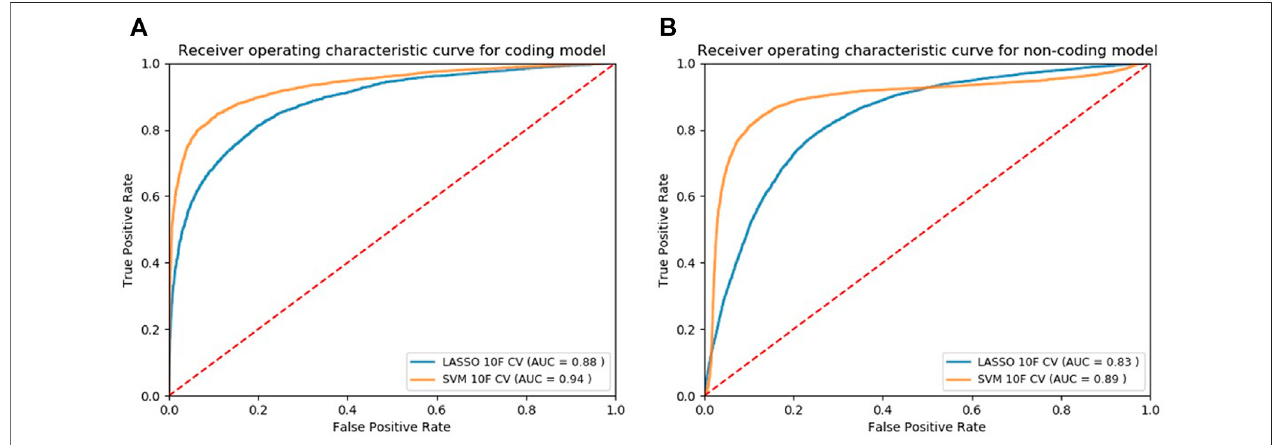
FIGURE 2 | ROC curves of the models designed for classifying cancer somatic variants from coding (A) and non-coding (B) regions of the genome.